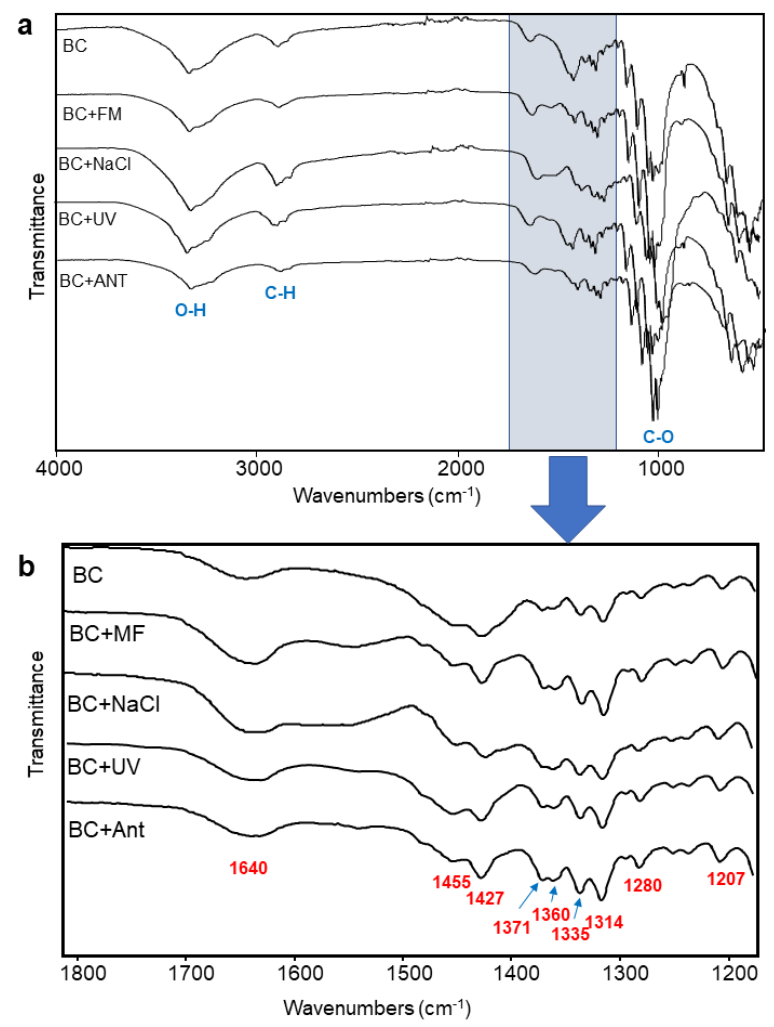
Figure 4. FTIR spectra of ( a ) bacterial cellulose (BC) with and without treatment and ( b ) its expanded region from 1800 to 1200 cm ‐ 1 .